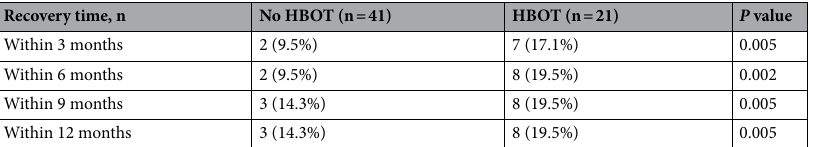
Table 3. Recovery time for patients with and without HBOT after DNS development. Categorical data are presented as frequency (proportion). HBOT hyperbaric oxygen therapy, DNS delayed neuropsychiatric sequelae.